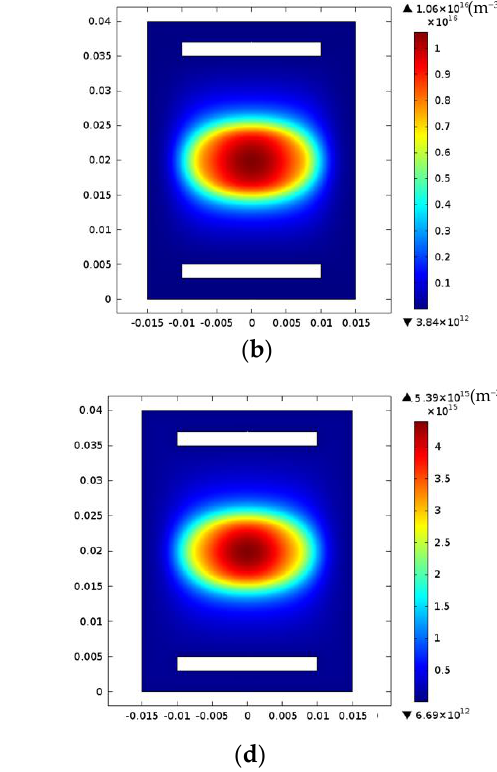
Figure 5. Density distribution of ( a ) atomic oxygen (O), ( b ) excited oxygen atoms O * ( 1 D), ( c ) exited argon atoms (Ar * ), and ( d ) ozone O 3 at 0.3 Torr total gas pressure, RF voltage (150 V, 13.56 MHz), and 20% O 2 .